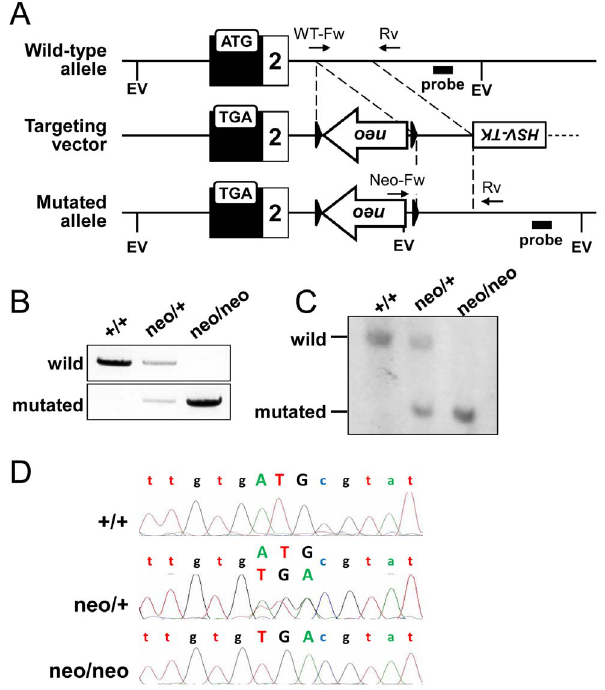
Figure 2. Generation of Runx2-I -targeted mice. (A) Schematic representation of the targeting strategy. A targeting construct was designed to replace the start codon (ATG) of Runx2-I with a stop codon (TGA). Relevant Eco R V (EV) recognition sites are indicated. (B) PCR analysis of the indicated Runx2-I -targeted mice. The primers depicted in panel (A) were used to detect the wild-type allele (WT-Fw and Rv) or the mutated allele (Neo-Fw and Rv). The PCR products were 1.1 kb in size for both the wild-type and the mutated allele. + / + , wild-type; neo/ + , heterozygous; neo/neo, homozygous. (C) Confirmation of recombina- tion by Southern blot analysis using the genome of Runx2-I -targeted littermates after digestion by Eco R V. The membrane was blotted with the probe shown in panel (A). The size of the band was 7.2 kb in the wild-type allele and 2.2 kb in the mutated allele. (D) Sequence analysis of the first ATG of Runx2-I in the mice of each genotype. The genome sequence was amplified by using the set of primers flanking the first ATG region, and the amplified fragment was read by the DNA sequencer.